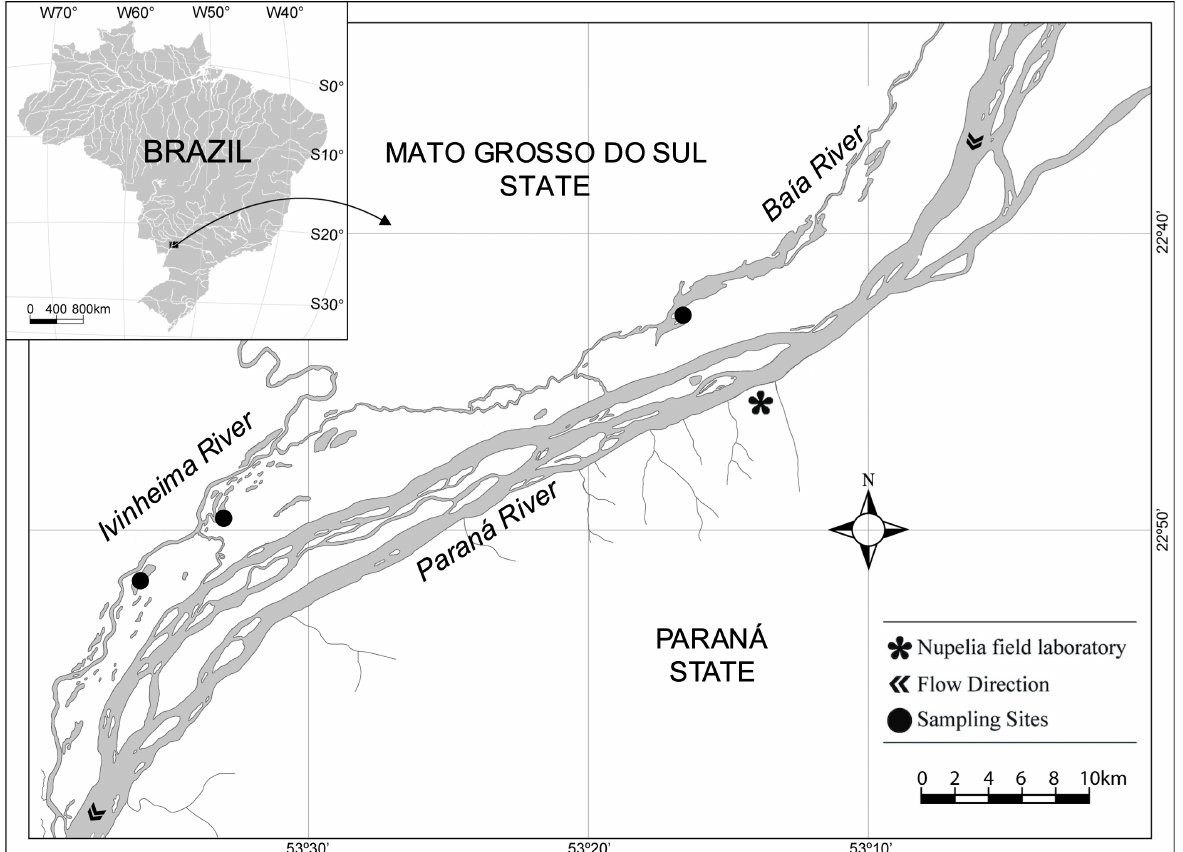
Figure 1. Study area. Points (•) indicate the ponds in which the fish samples were taken in the Upper Paraná River floodplain, located in southern